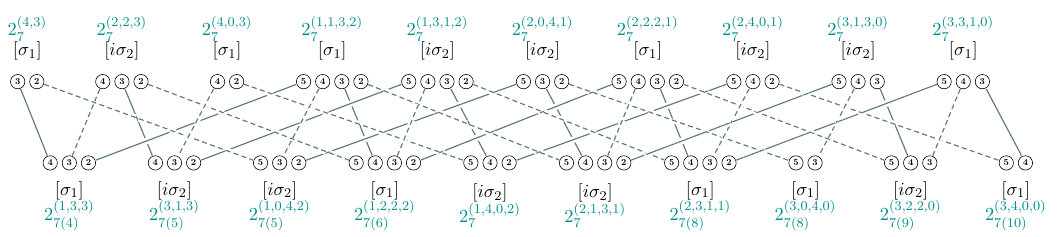
Figure 13 . T -duality chain of the E (7;6) -branes.